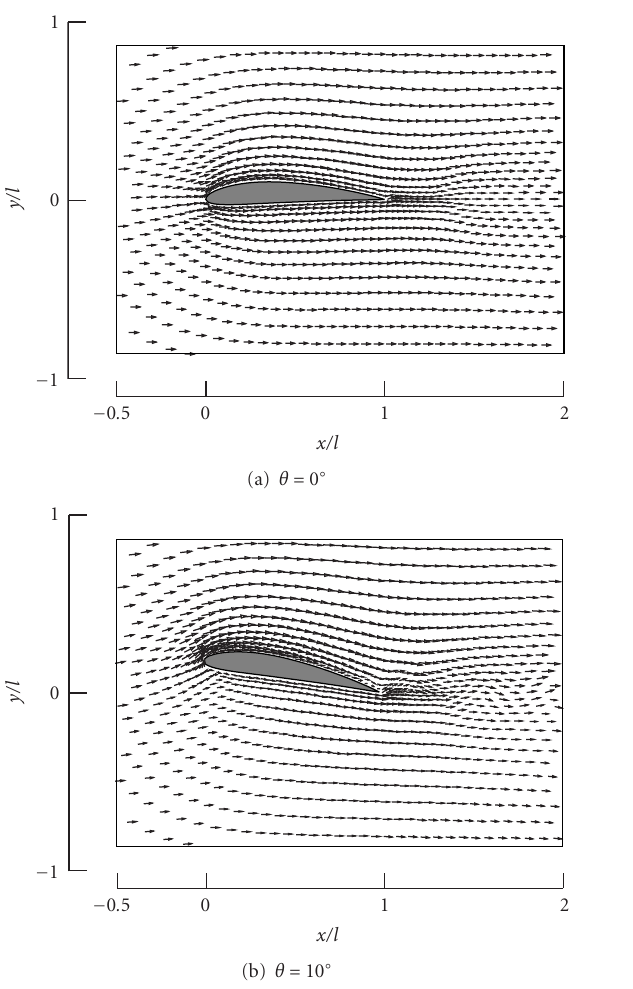
Figure 3: Distribution of water velocity.